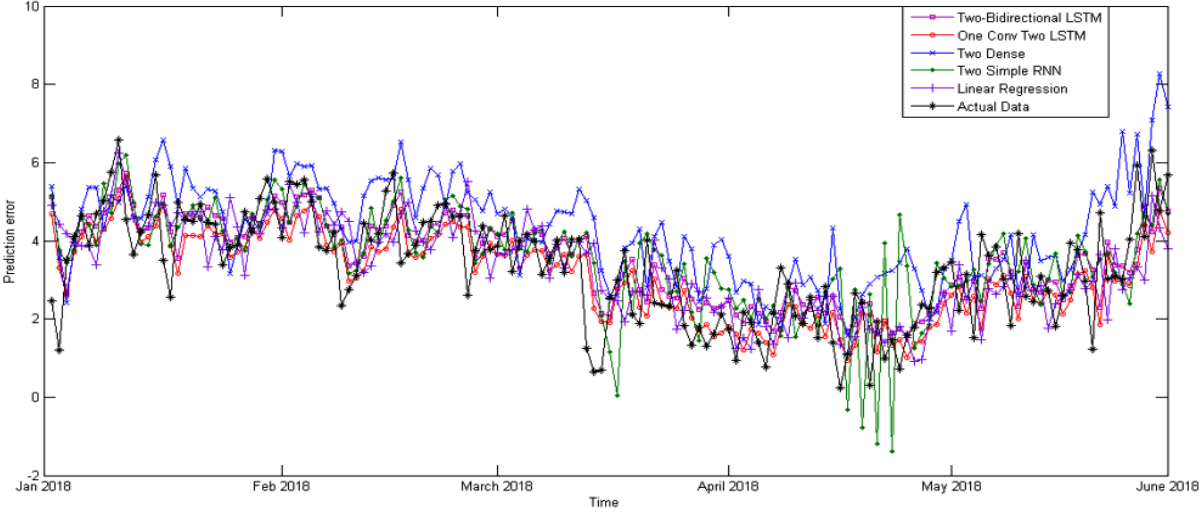
Figure 5. Prediction plot of wind speed data of various model in Madurai Dataset from Jan 2018 to June 2018.